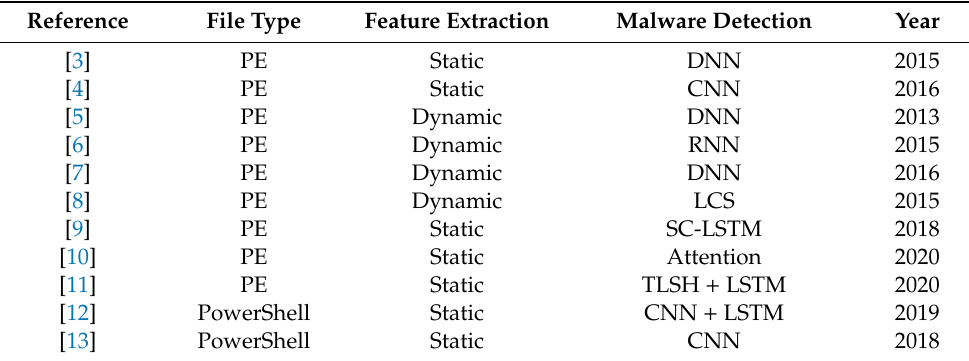
Table 1. Comparison of AI-based Detection.